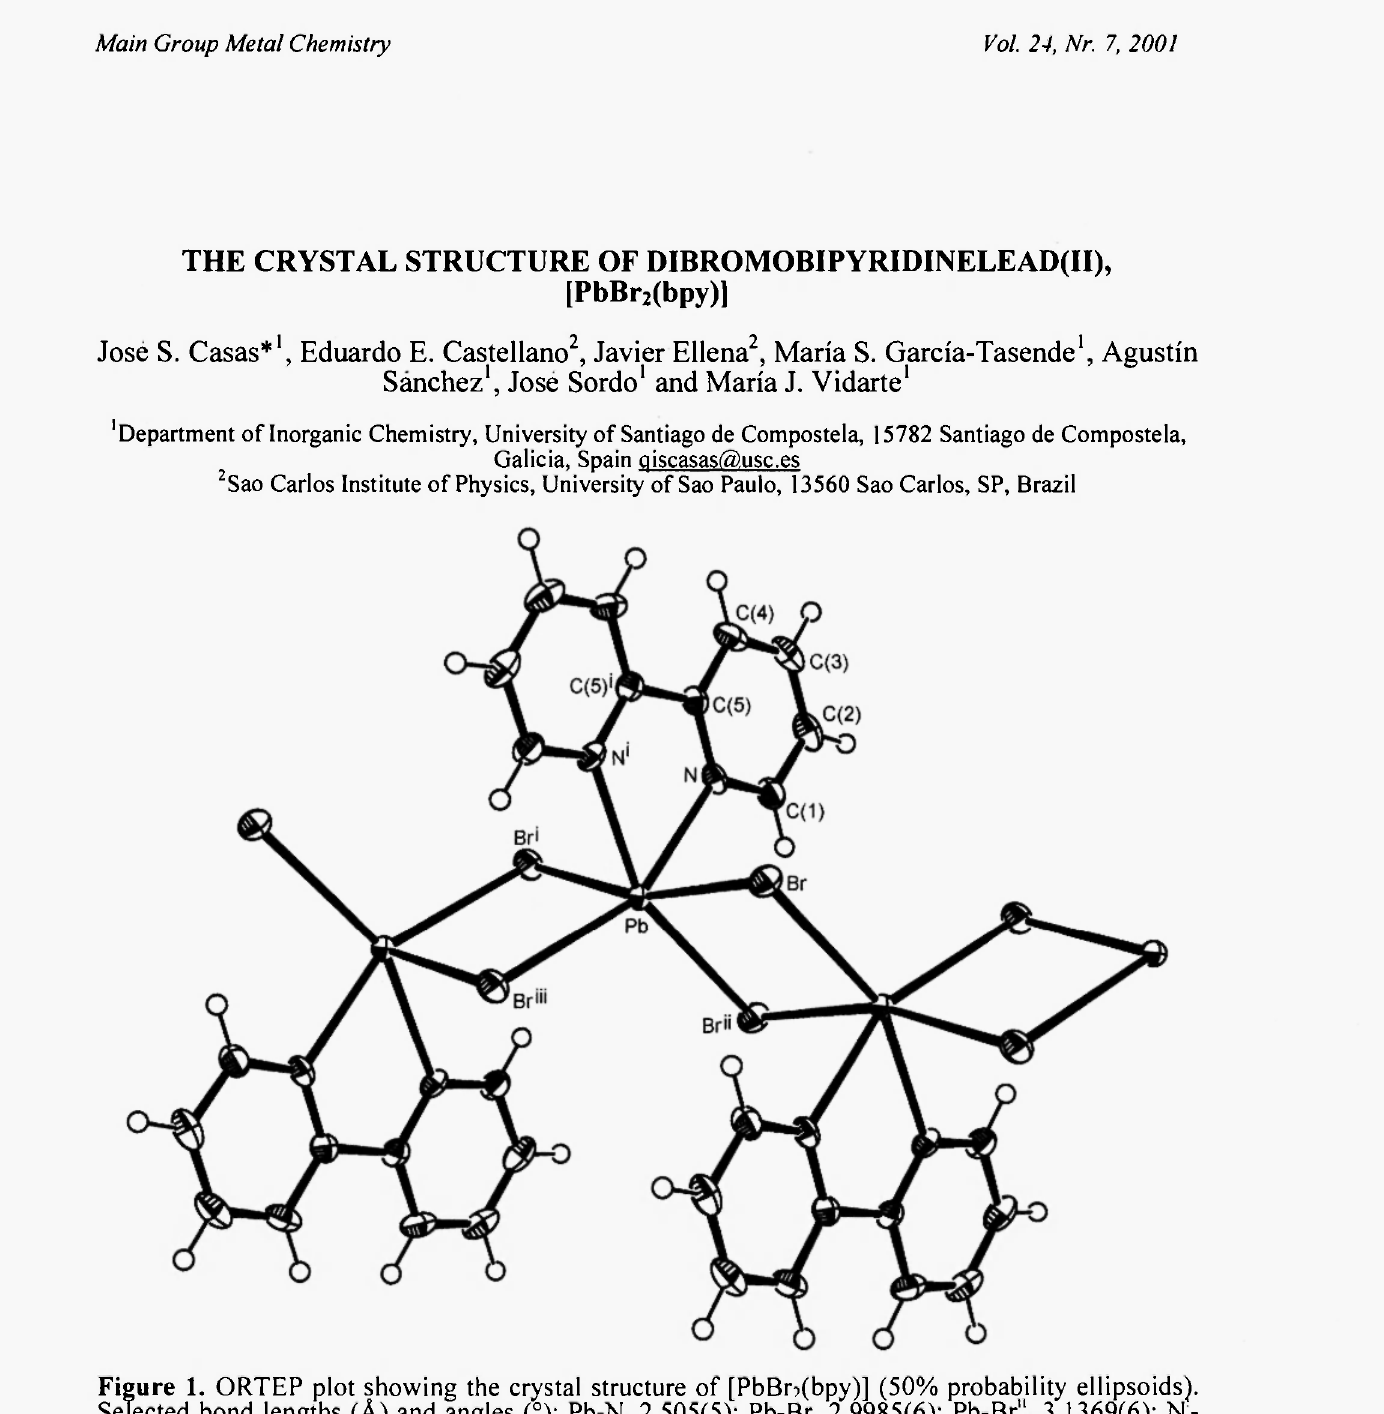
Figure 1. ORTEP plot showing the crystal structure of [PbBn(bpy)] (50% probability ellipsoids). Selected bond lengths (A) and angles (°): Pb-N, 2.505(5); Pb-Br, 2.9985(6); Pb-Br", 3.1369(6); N- Pb-N, 65.4(2); N'-Pb-Br, 83.06(10); N-Pb-Br, 84.08(10); Br-Pb-Br 1 , 164.69(3); N'-Pb-Br", 155.18(12); N-Pb-Br", 90.11(12); Br-Pb-Br", 90.650(16); Br'-Pb-Br", 97.622(18); Br"-Pb-Br'", 114.56(3). Symmetry operations: i, -x, y, -z+0.5; ii, -x, -y, -z; iii, x, -y,